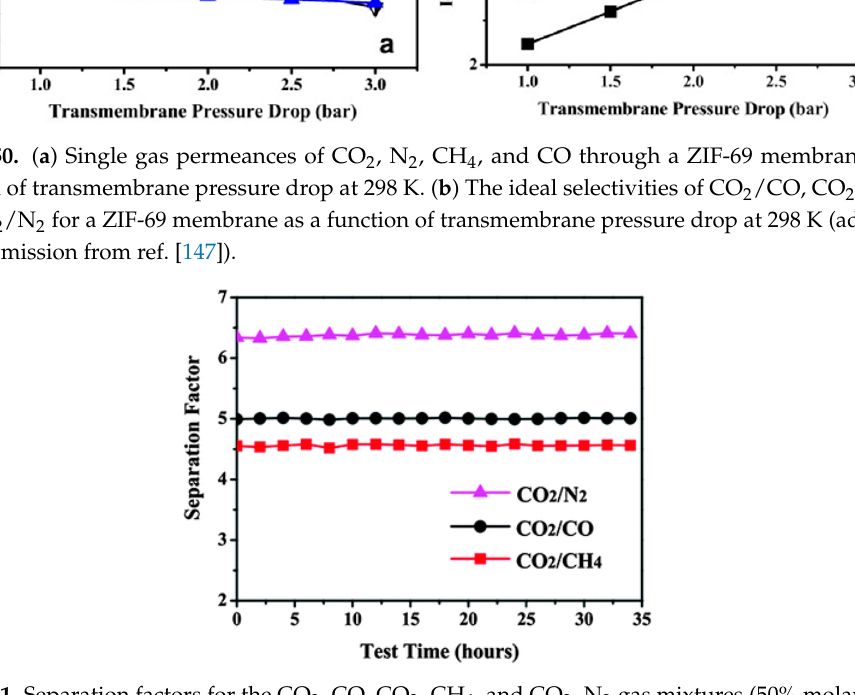
Figure 51. Separation factors for the CO 2 –CO, CO 2 –CH 4 , and CO 2 –N 2 gas mixtures (50% molar each) as a function of test time for the ZIF-69 membrane at 298 K (adapted with permission from ref. [147]).